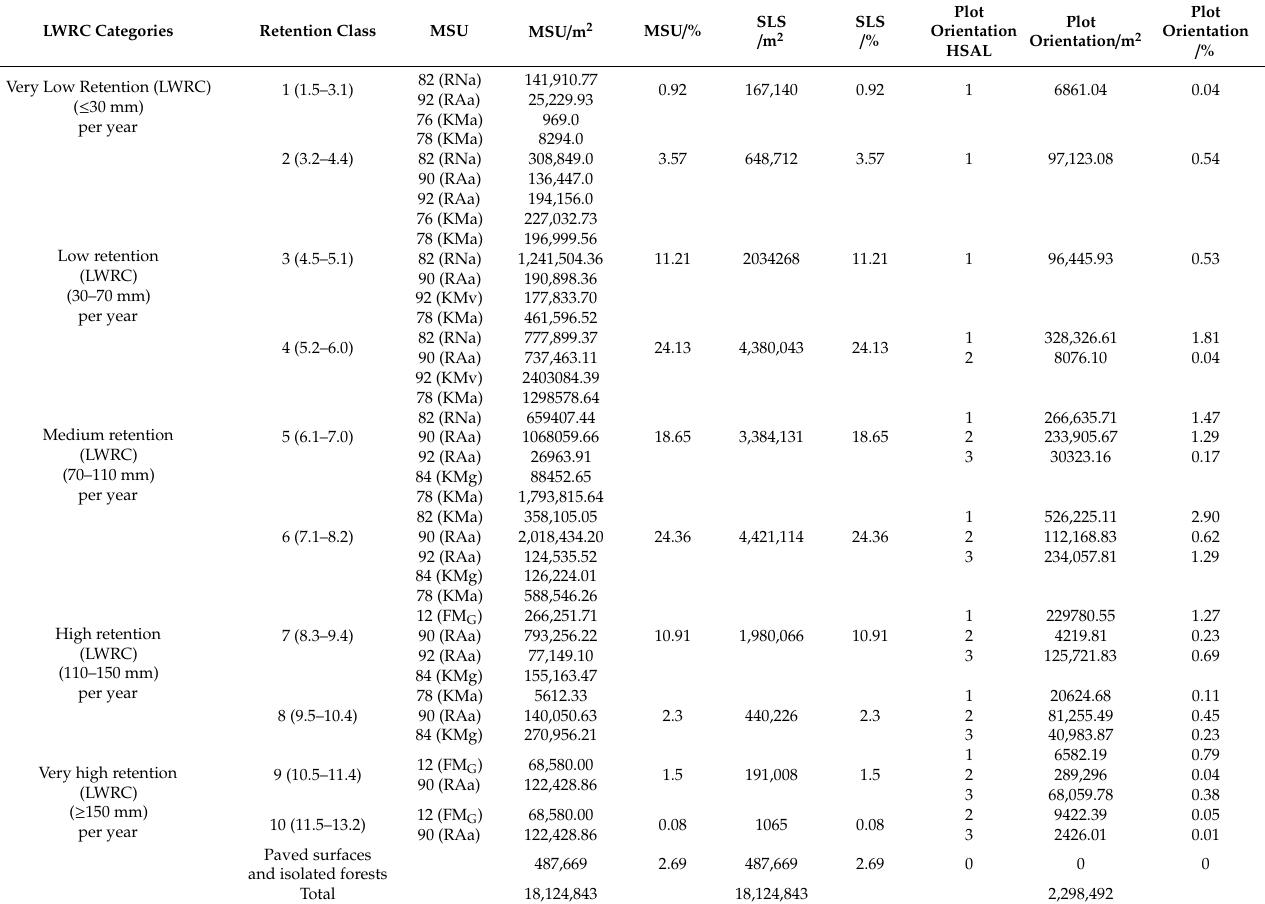
Legend: Main soils units (MSU) correlation according to The World Reference Base for Soil Resources (IUSS Working Group WRB, 2014): 12 (FM G )—Gleyic Fluvisol (Clayic), 76 (KMa)—Skeletic Dystric Cambisol (Loamic, Aric) on crystalline rocks., 78 (KMa)—Skeletic Dystric Cambisol (Loamic, Aric) on flysch rocks, 82—(KNa) Skeletic Dystric Cambisol (Loamic, Aric) on a flysch rocks, on steep slopes, 12–25 ◦ , 84 (KMg)—Stagnic Cambisol (Loamic / Clayic) on steep slopes, 12–25 ◦ , 90 (RAa)—Rendzic Calcaric Eutric Leptosol (Loamic), and 92 (RAa)—Rendzic Calcaric Eutric Leptosols (Loamic) on steep slopes 12–25 ◦ . Plot orientation: 1—perpendicular to contour lines, 2—diagonal to contour lines, and 3—along the contour